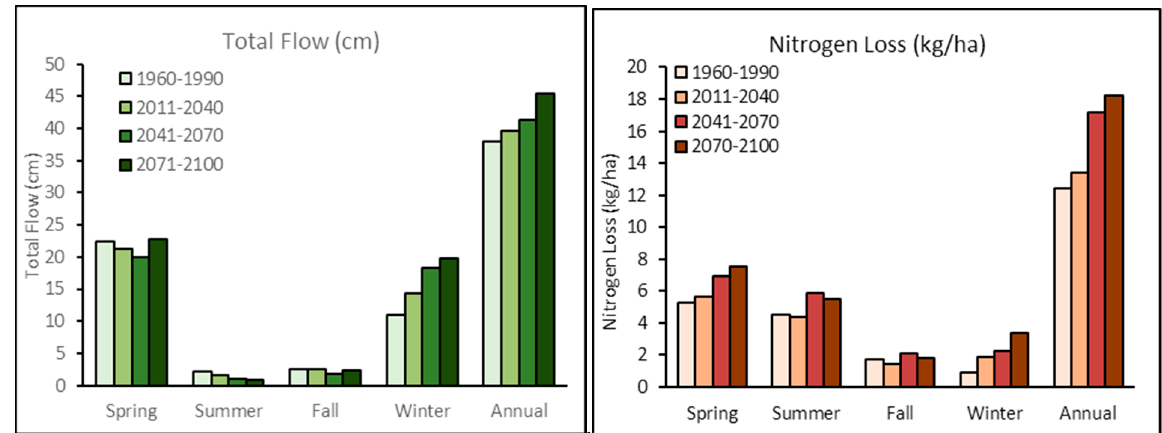
Figure 7. Historical (1960–1990) and future (2011–2100) simulated seasonal and annual average total tile flows (left) and NO 3 -N loss (right).